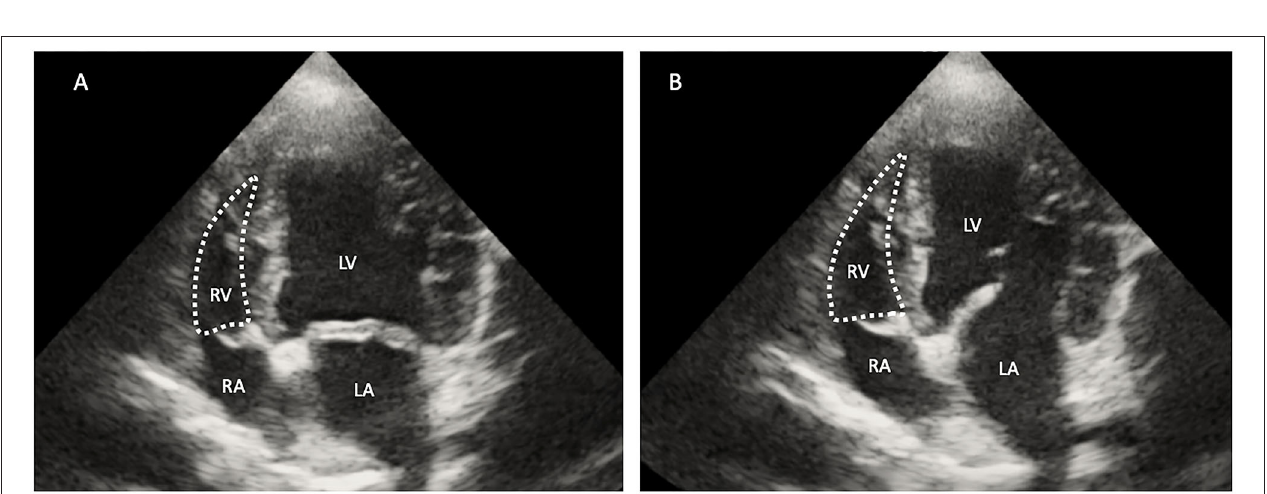
FIGURE 2 | Measurement of right ventricular dimensions by the apical four-chamber view. (i) the basal distance measurement, (ii) the mid-right ventricular measurement, and (iii) the base to apex measurement.